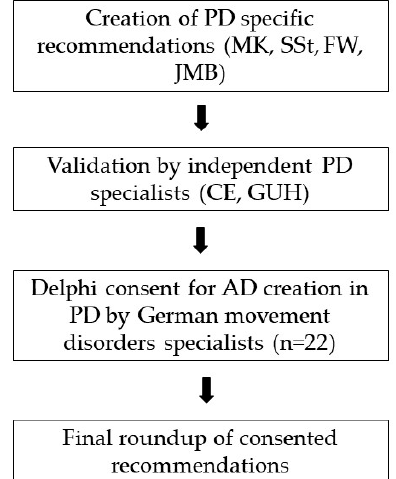
Figure 1. Study design. Abbreviations: PD Parkinson’s disease; AD advance directive.